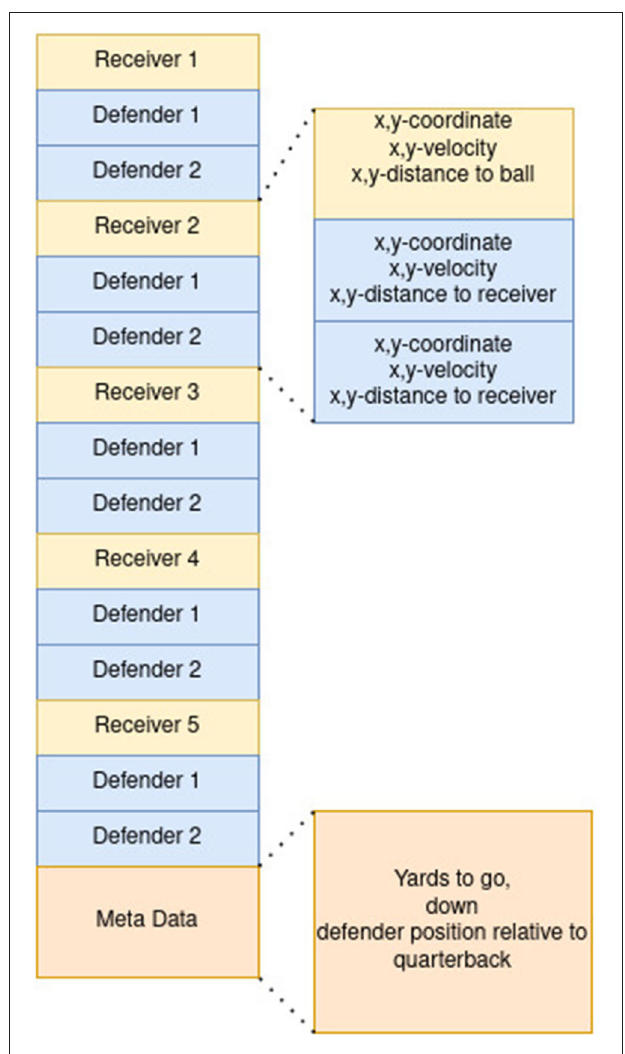
FIGURE 2 | Feature Vector of the pass completion